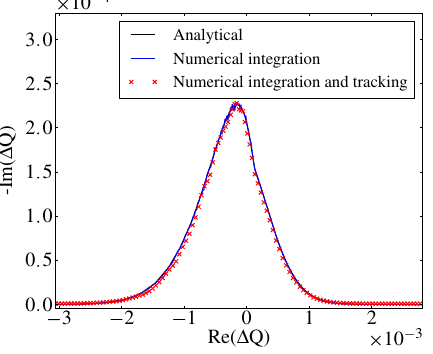
FIG. 3. Comparison of analytical [2] and numerical derivation of a stability diagram with LHC octupoles powered with − 500 A for a 4 TeV beam with a normalized emittance of 2 μ m.